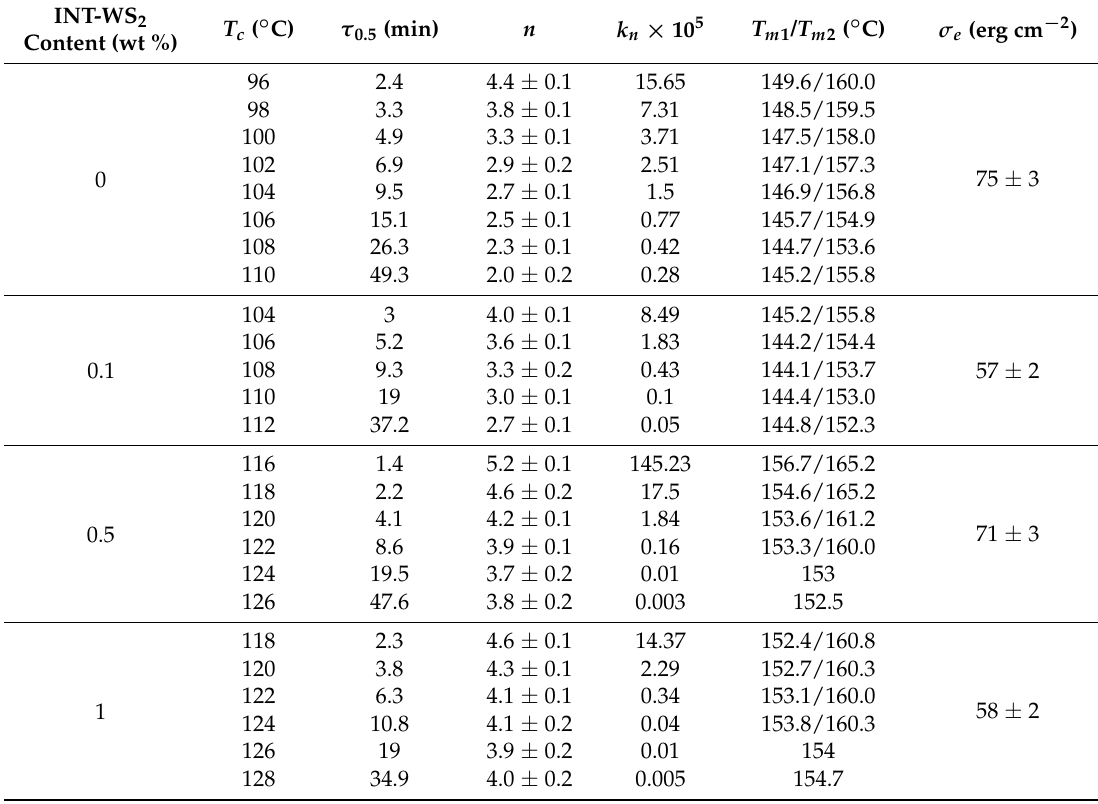
Table 1. Isothermal crystallization parameters of PHBV and PHBV/INT-WS 2 nanocomposites. T c = crystallization temperature, τ 0.5 = the time needed to reach 50% crystalline transformation, n = Avrami exponent, k n = overall rate constant, T m = melting temperature and σ e = fold surface free energy. (*) The main error arises from baseline selection during data processing. We estimate the following errors: ± 1 J/g for ( ∆ Ht ) and ± 100 for ∆ ( τ 0.5 ). INT-WS 2 Content (wt